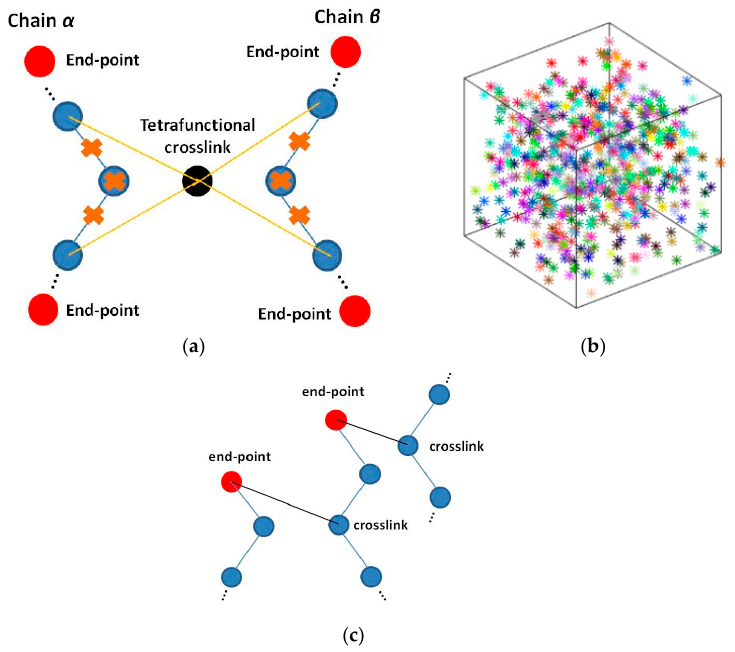
Figure 2. ( a ) Schematic representation of a tetrafunctional crosslink created by random crosslinking; ( b ) visualization of 600 crosslinks randomly dispersed in a cubic simulation box of edge length 30 nm (after the implementation of random crosslinking); ( c ) crosslinking through end-grafting: conversion of an internal nodal point to a trifunctional crosslink which is connected with an end-point of another polymer chain.